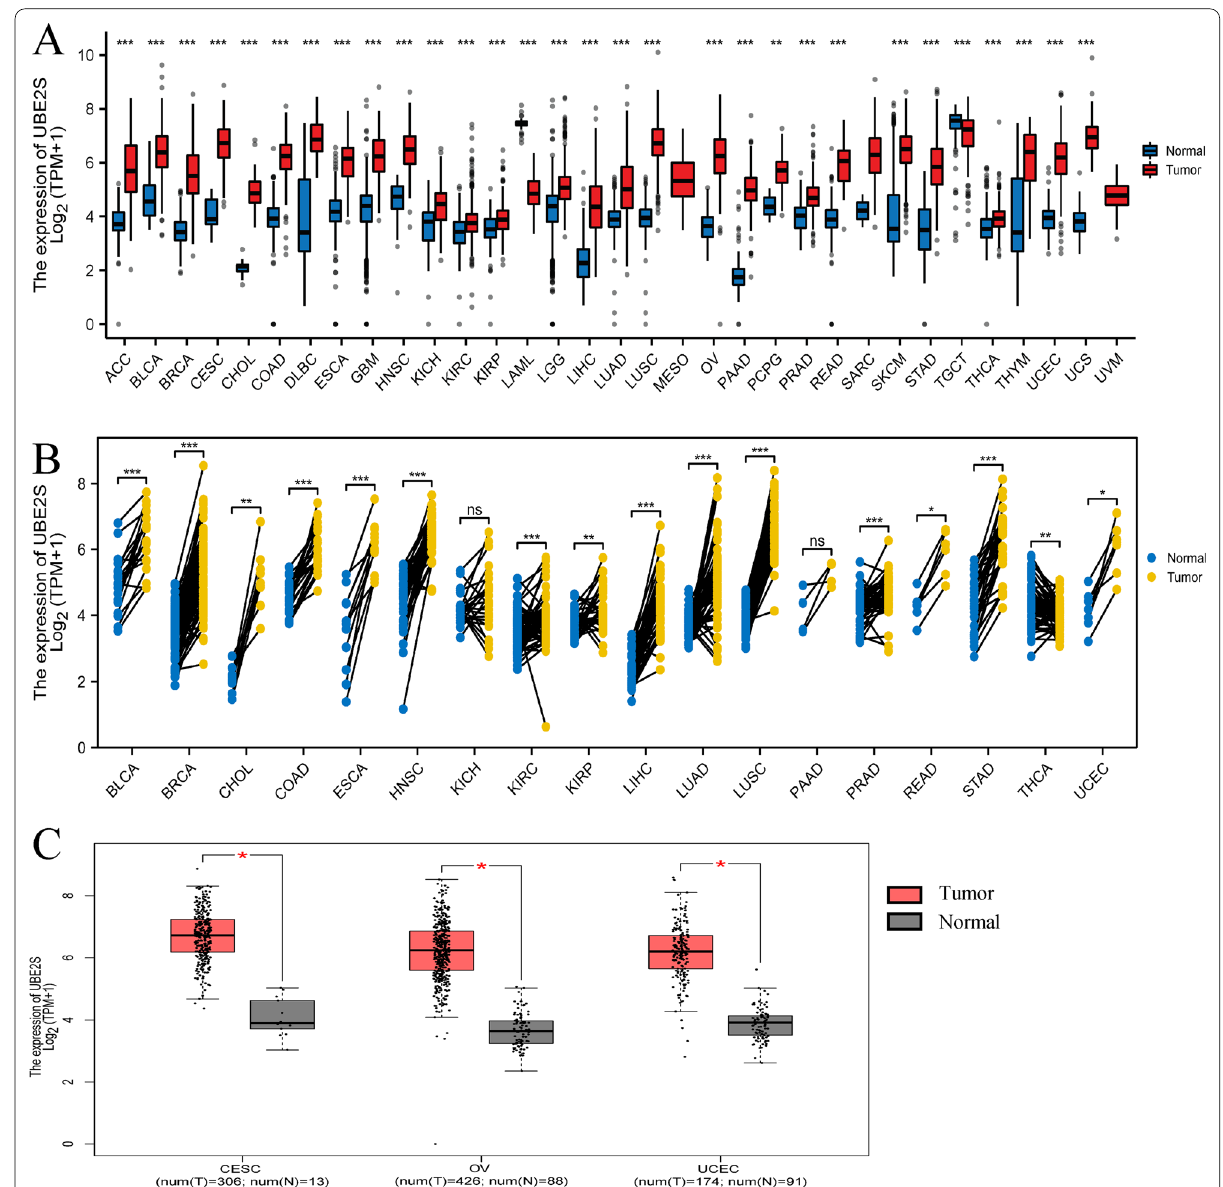
Fig. 1 UBE2S mRNA expression at the pan-cancer level. A UBE2S mRNA expression level in 33 types of human tumor tissues and corresponding normal tissues from GEPIA databases. UBE2S was significantly highly expressed in 18 types of cancer tissues. B UBE2S mRNA expression level in 18 types of human tumor tissues and matched adjacent normal tissues from TCGA databases. UBE2S was significantly highly expressed in 15 types of cancer tissues. C UBE2S mRNA expression level in CESC, OV, UCEC tissues and the corresponding normal control tissues (normal cervix, normal ovary and normal endometrial tissue) from GEPIA databases. The number of tissue samples was detailed in parentheses in the figure. (*P < 0.05, **P < 0.01, ***P < 0.001, ****P <